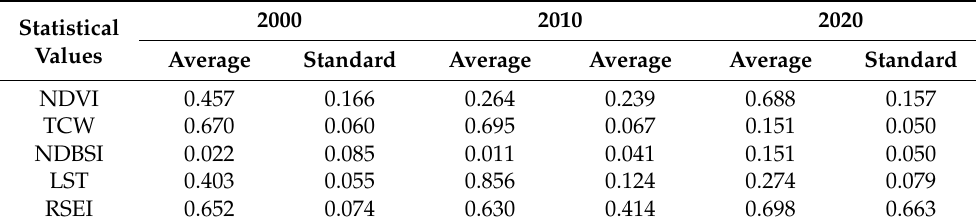
Table 5. Normalized values for the four indicators and RSEI statistics.